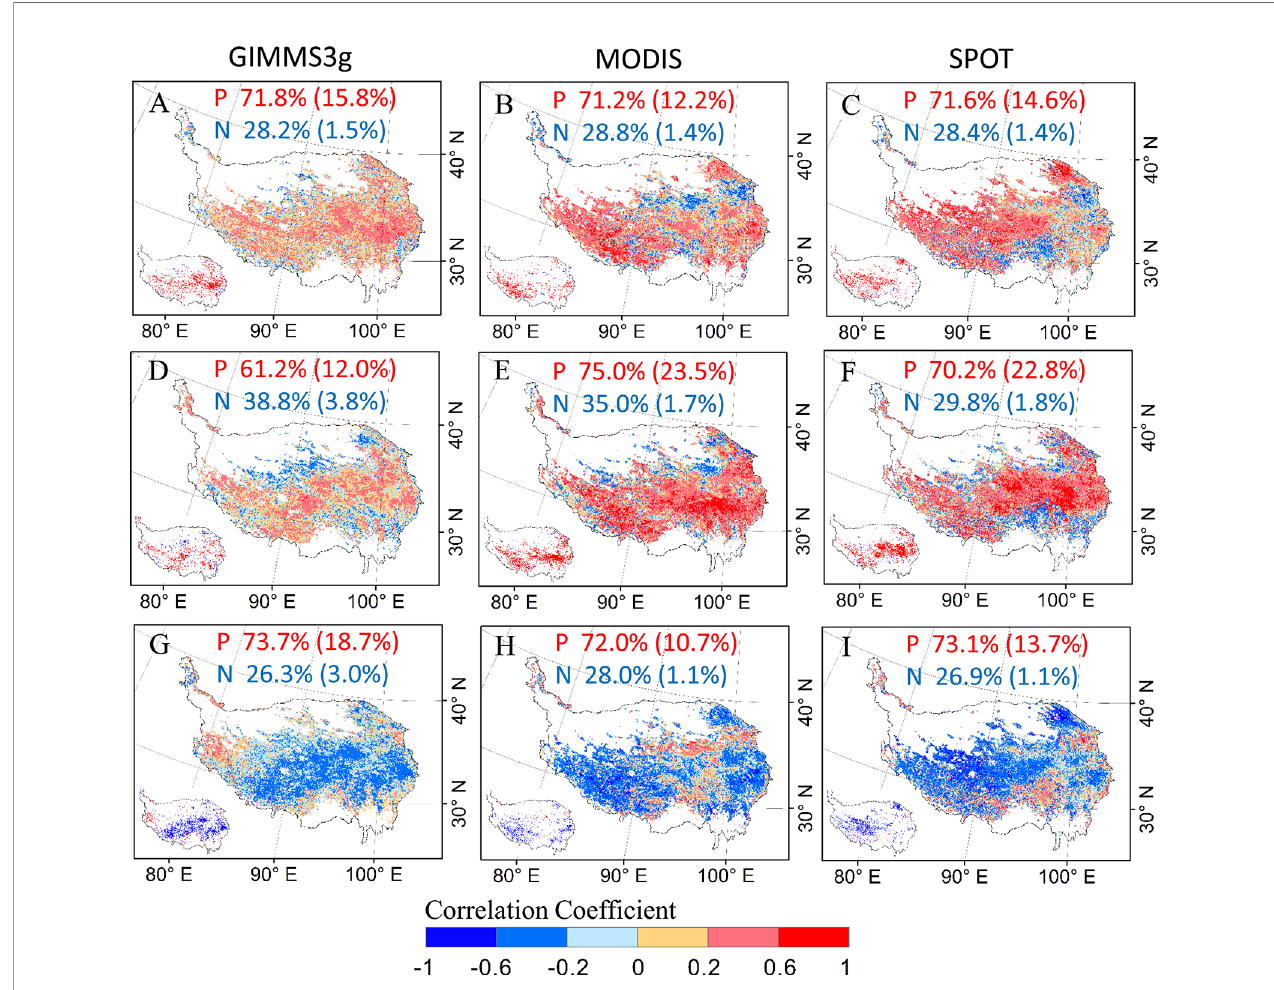
FIGURE 6 | The spatial patterns of partial correlation coef fi cients between vegetation DOD of GIMMS3g (1982 – 2012), SPOT (2000 – 2012), and MODIS (2000 – 2012) NDVI data sets and climatic factors for preseason period. (A – C) for the temperature, (D – F) for the precipitation, (G – I) for the cold degree days. The inset panels in the bottom left of each submap present the pixels with a signi fi cantly (P < 0.05) positive (red) and negative (blue) value. The percentages of positive (P) and negative (N) correlations (percentage of signi fi cant correlations in parentheses) are shown at the top of each